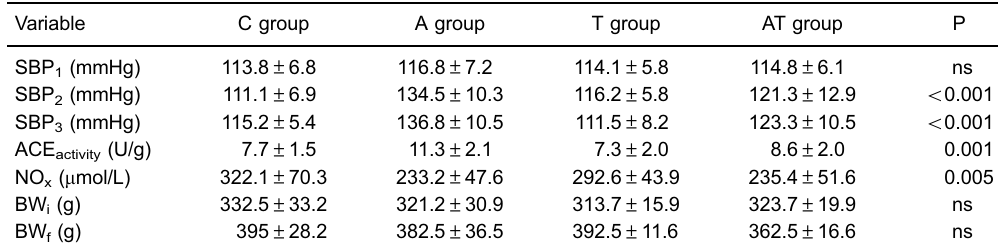
Table 1 . Values of systolic blood pressure, biochemical parameters and body weight in rats treated with nandrolone decanoate (A), taurine (T) and their combination (AT), or with vehicle (C). Variable